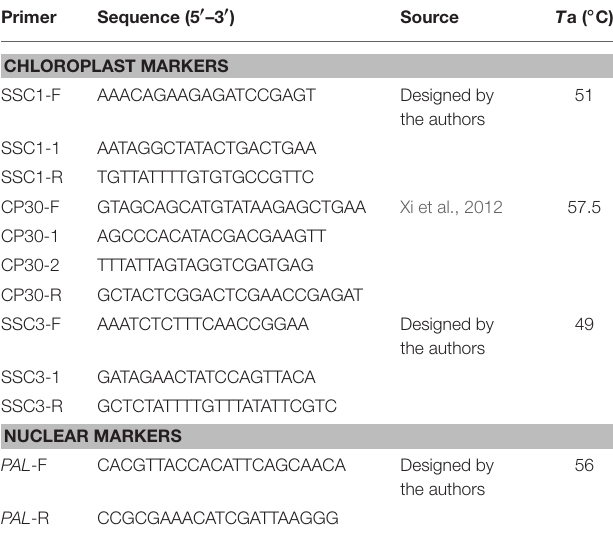
TABLE 3 | Primers used to amplify and sequence DNA from C.